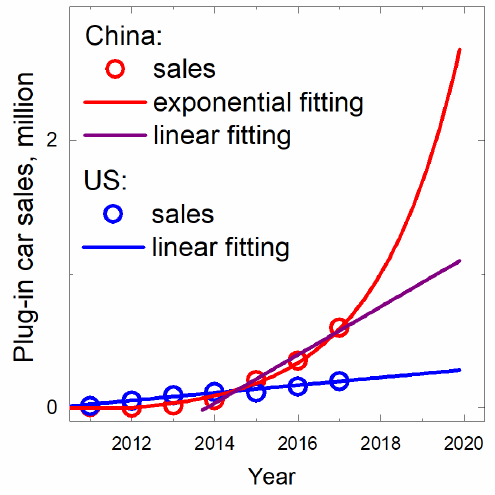
Figure 3. New energy vehicle (NEV) sales estimations for China and the United States.